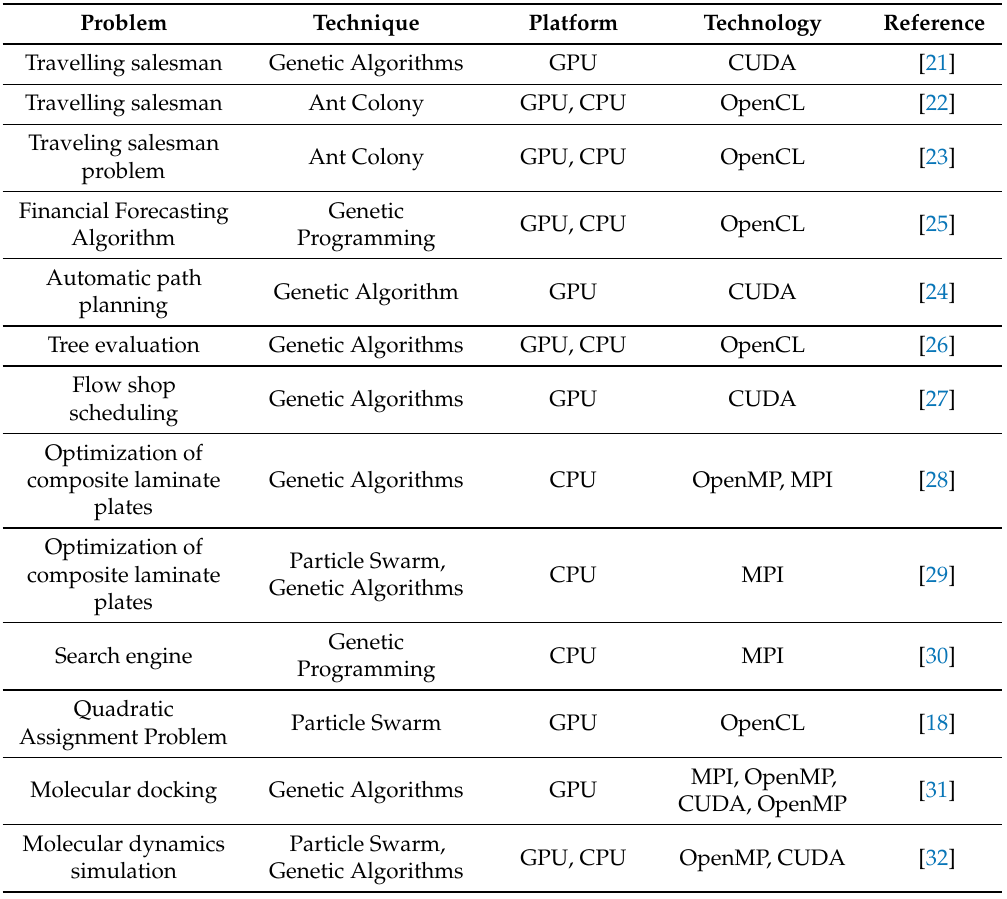
Table 1. Overview of parallel metaheuristic